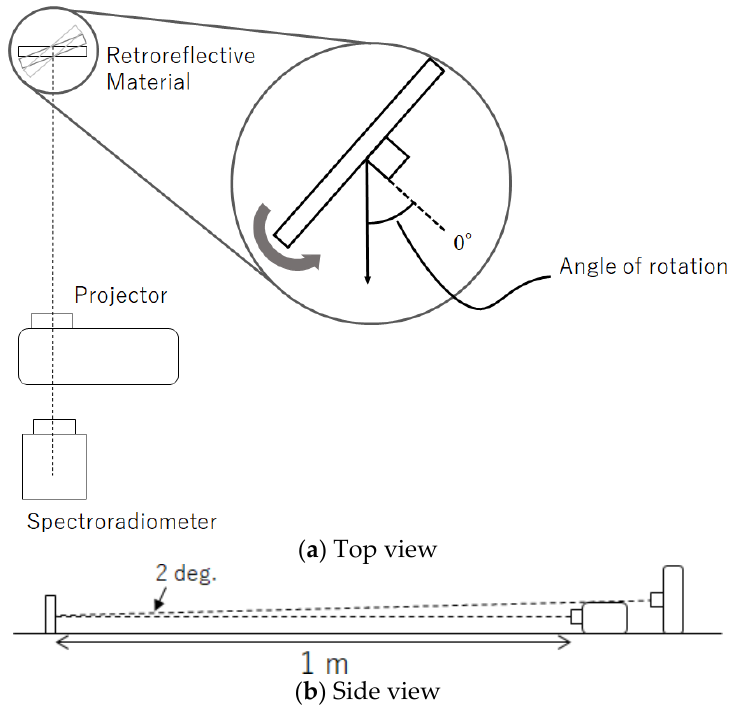
Figure 2. Measurement environment.